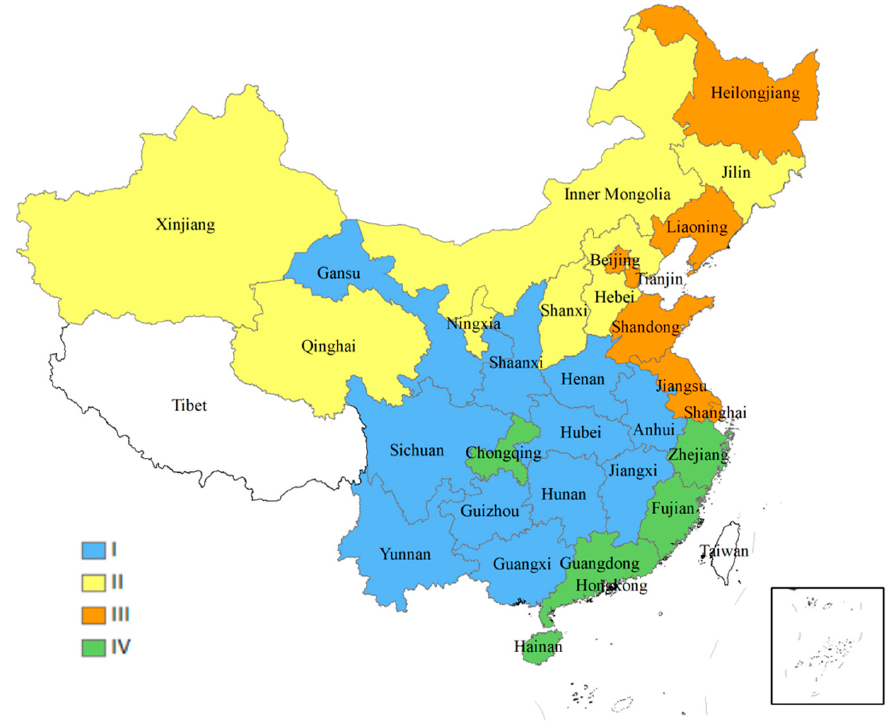
Figure 7. Locations of EWP effectiveness types of 30 provinces in China.